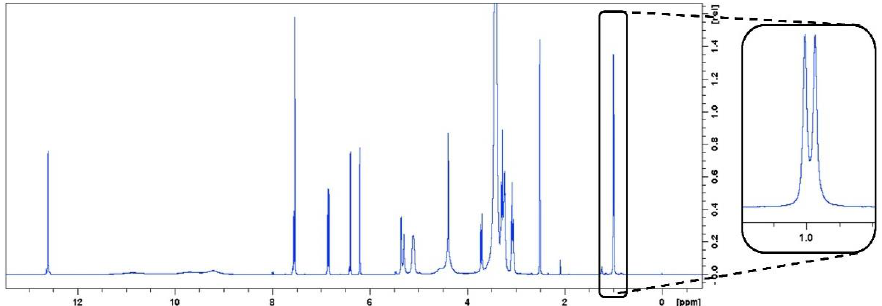
Figure 3. 1 H-NMR spectrum of rutin (400 MHz, DMSO- d 6 ). The outside expansion shows the doublet resonance of rutin:CH 3 -6 ’’’ in 0.990 ppm; it was used to quantitate this compound. Table 1. Results of the purity evaluation of the isolated hepatodamianol using a chromatographic- 150 based procedure and qNMR ERETIC2 tool (based in PULCON method). The % average value of 151 purity is shown, n = 3 measurements.